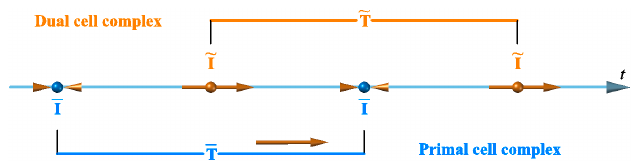
Figure 38. Time elements in the primal and dual cell-complexes.